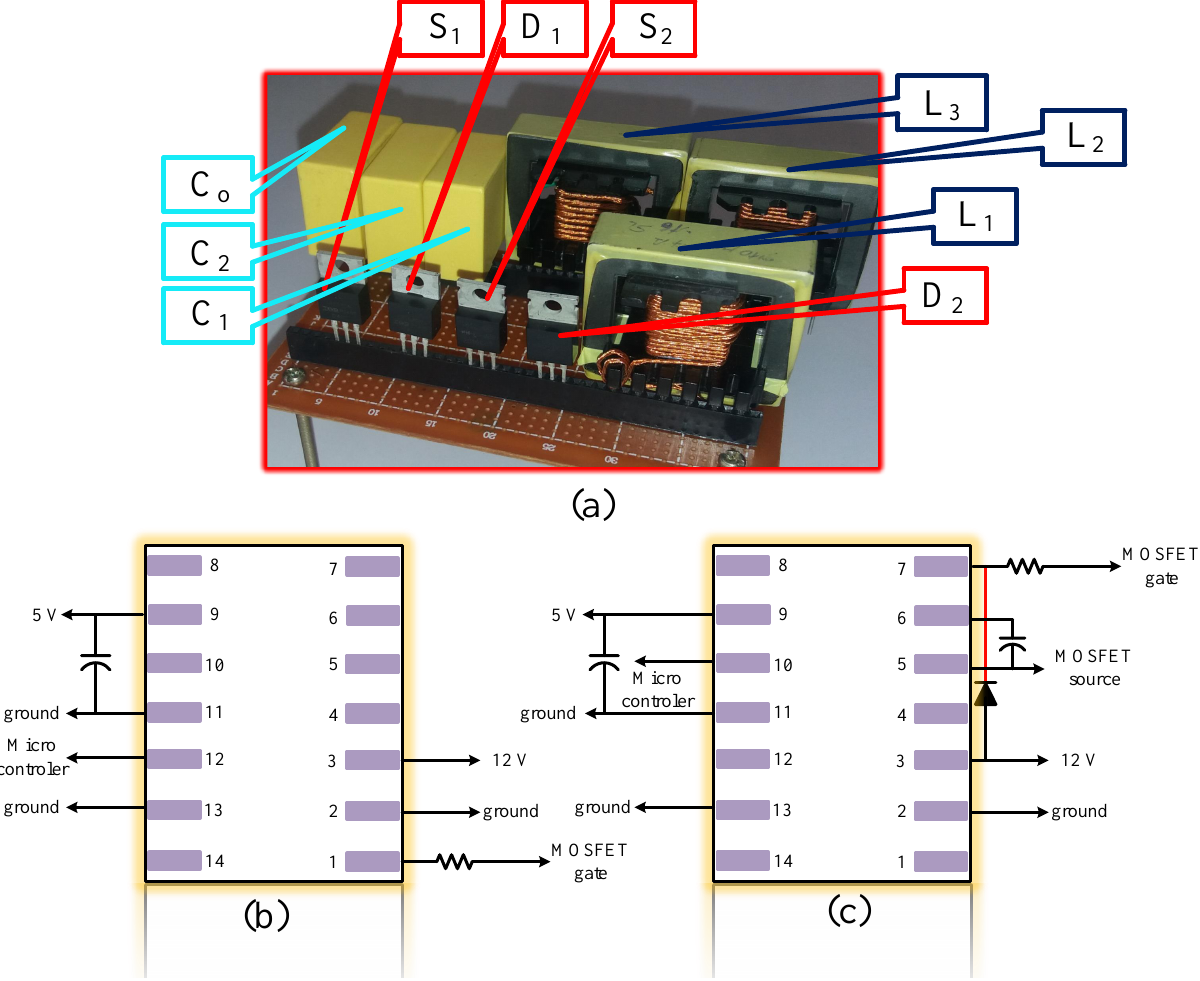
Figure 8. ( a ) The prototype; ( b ) driver of the low side switch; ( c ) driver of the high-side